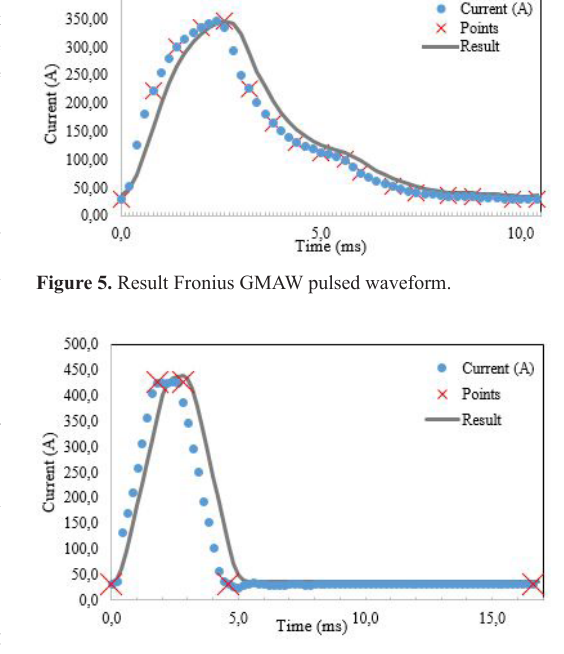
Figure 6. Result OTC GMAW pulsed